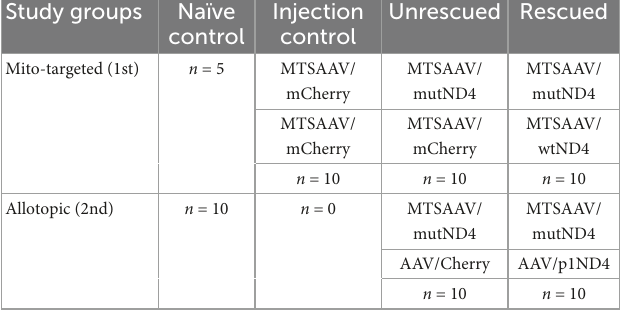
TABLE 1 Summary of